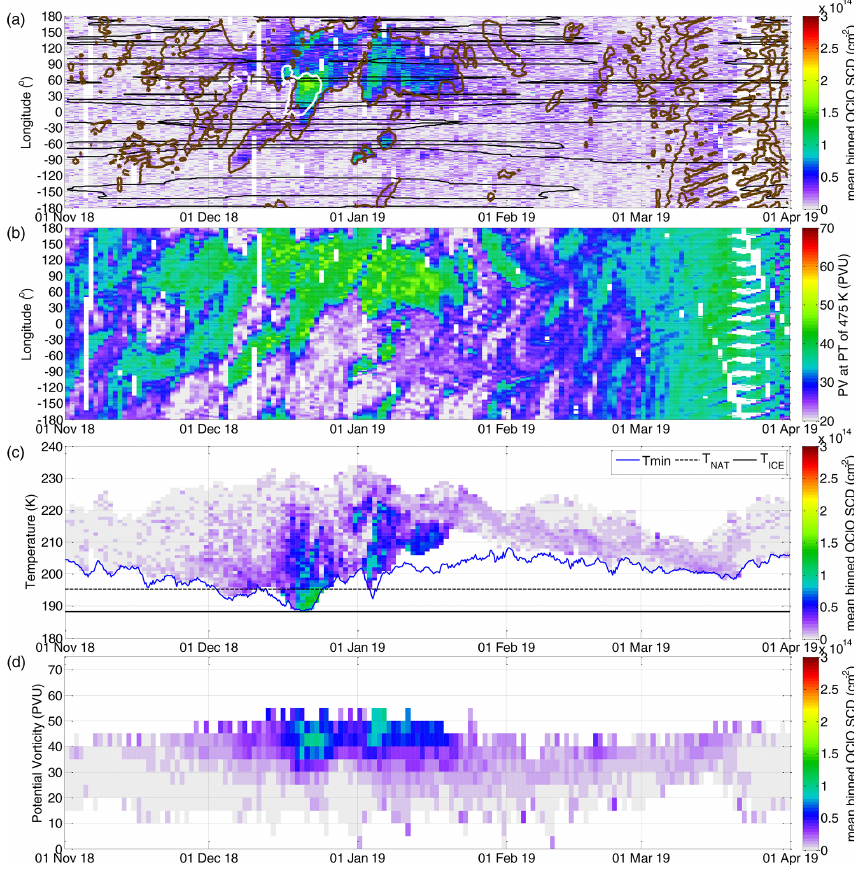
Figure 5. Same as Fig. 2 but for the Arctic winter